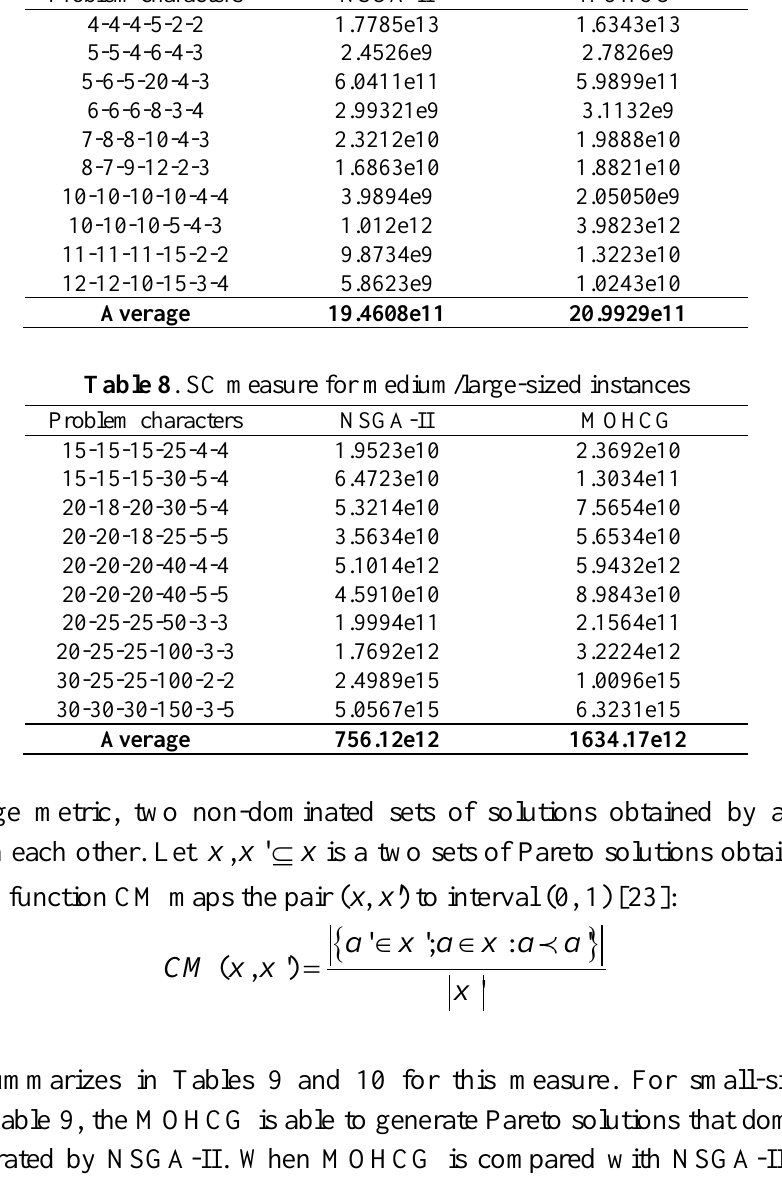
Table 7 . SC measure for small-sized instances Problem characters